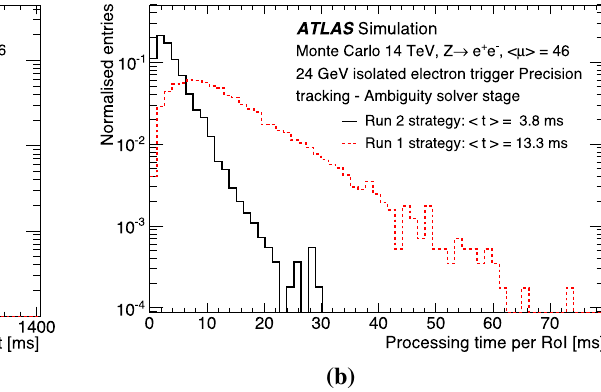
by the ambiguity solver in the Run 1 and Run 2 strategies. In all cases, the improved offline code implemented late in 2014 has been used